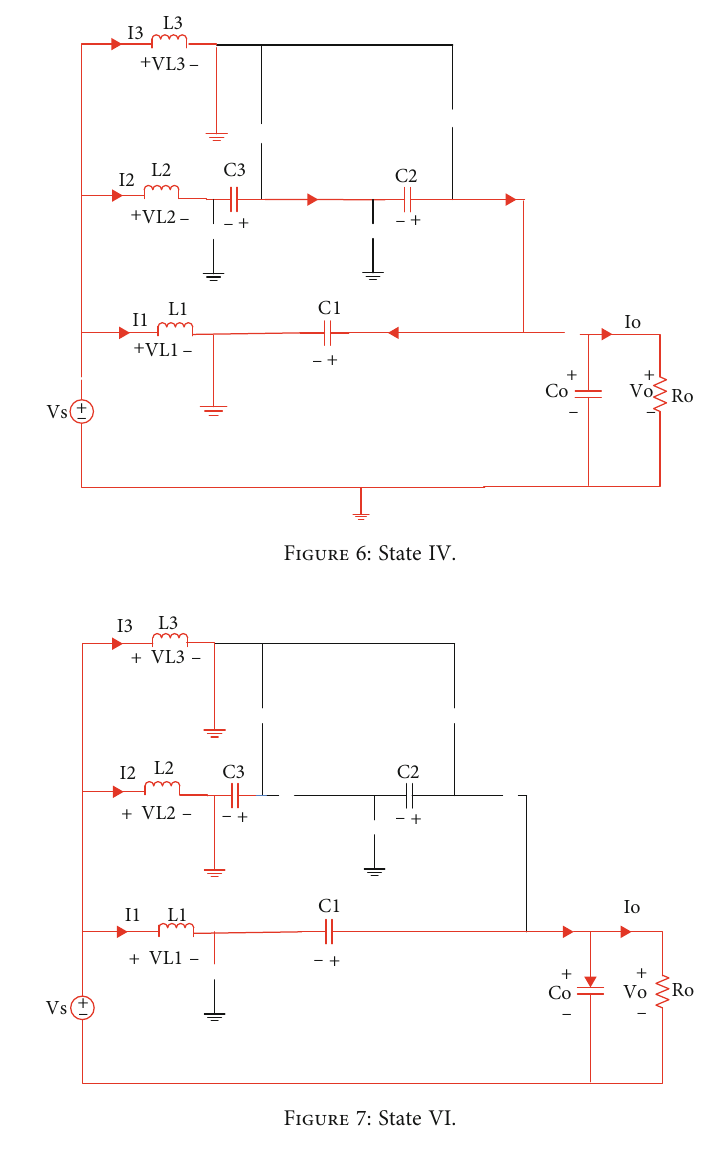
Figure 6: State IV.